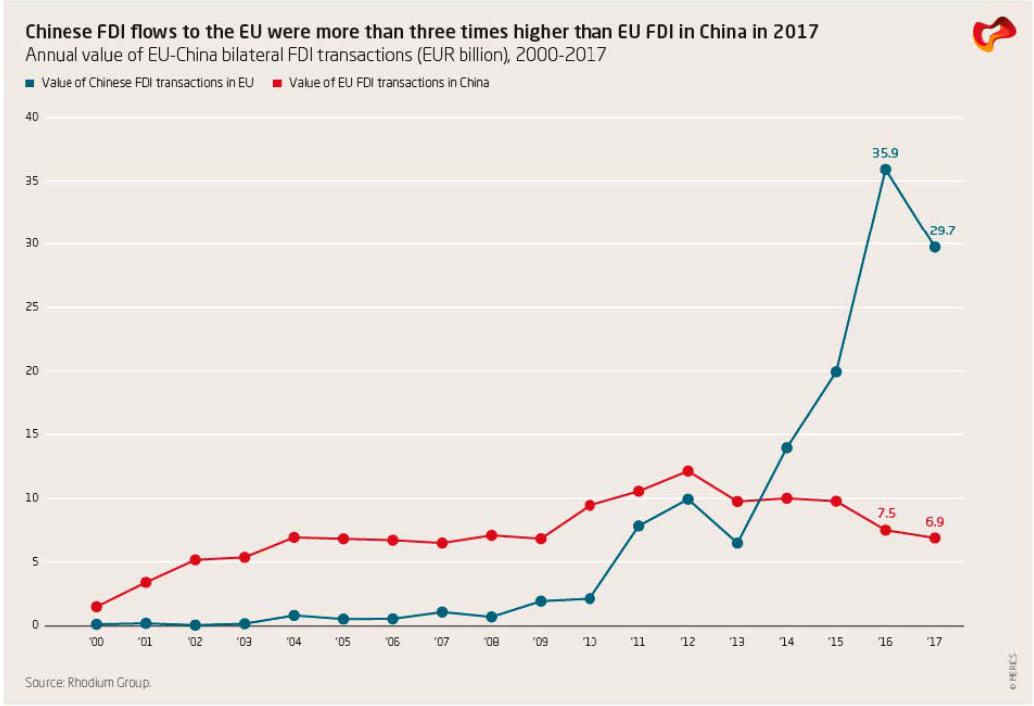
Figure 10 Bilateral FDI flows (2000–17). Source: Thilo Hanemann and Mikko Huotari, ‘EU–China FDI: Working Towards Reciprocity in Investment Relations’ (Mercator Institute for China 2018).